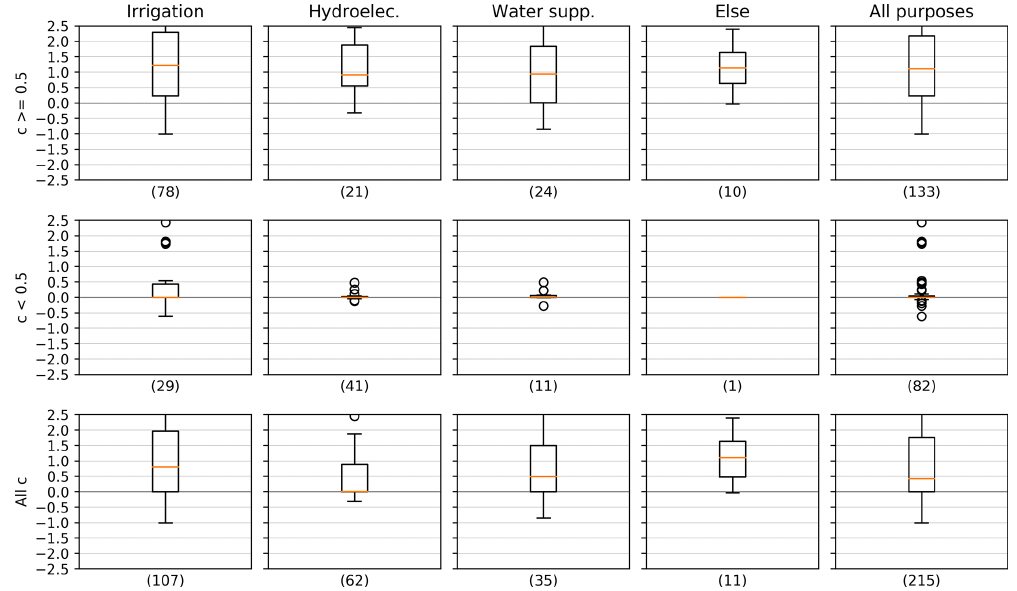
Figure 5. Distribution of river flow, C 2M , improvement rates with the DROP model based on their main purpose (columns) and relative capacity (rows). The x -axis labels show the number of reservoirs in each category, and the y axis shows C 2M improvement rates.